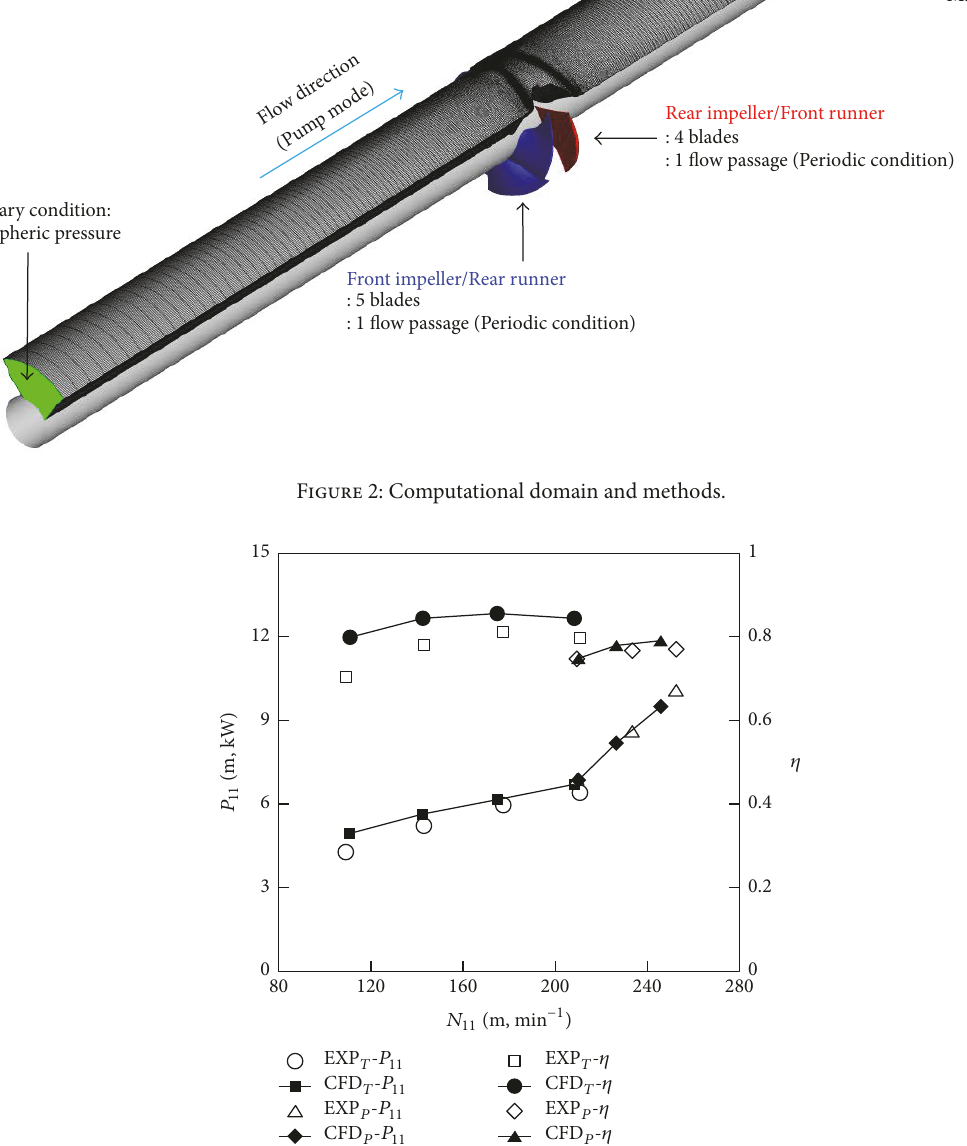
Figure 3: Validation assessment of the numerical results